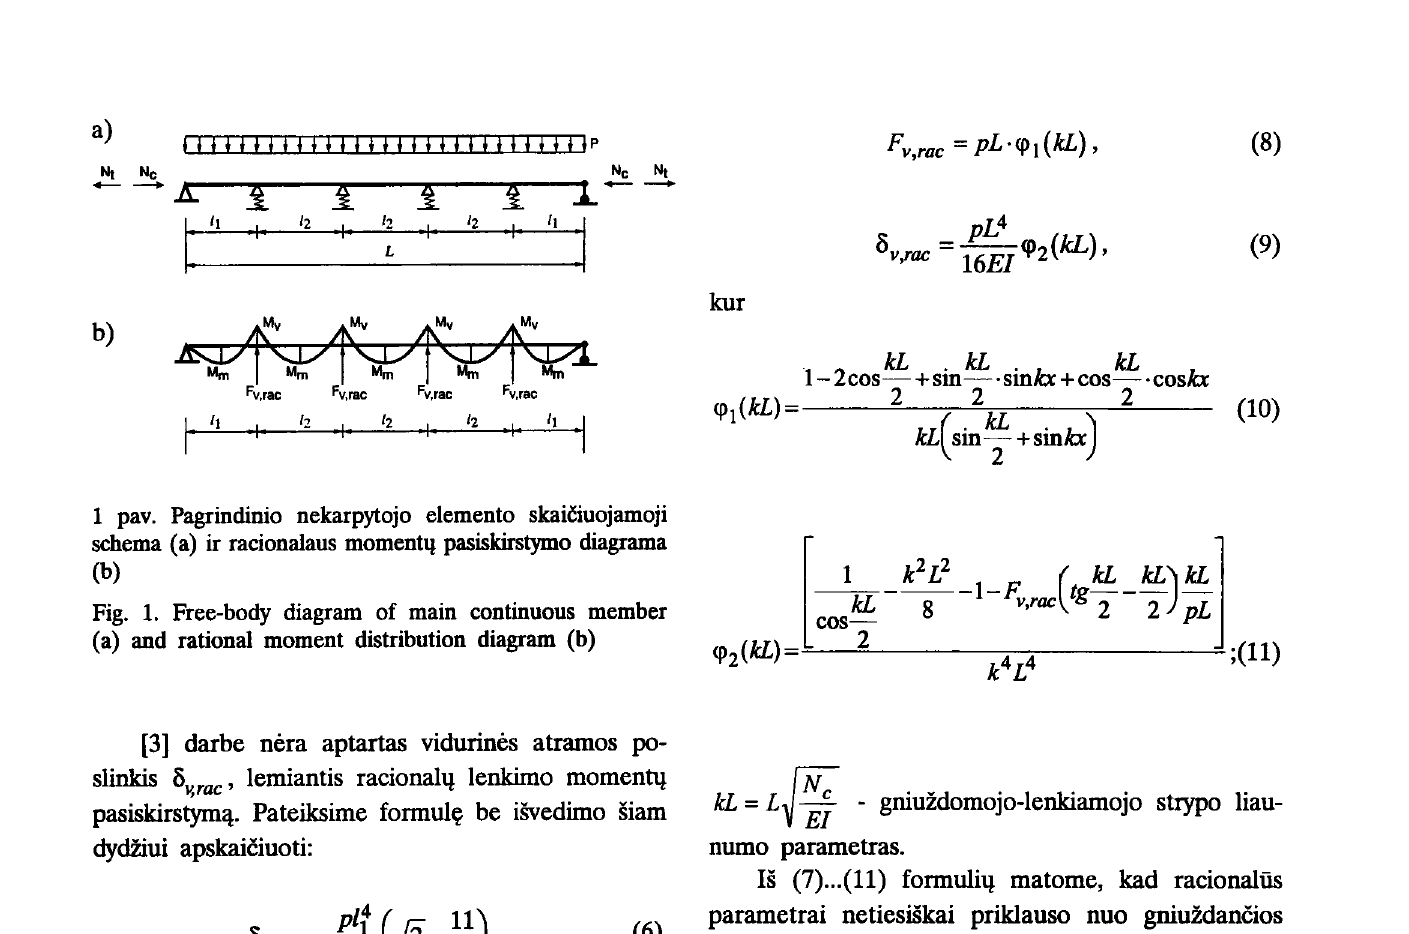
Fig. 1. Free-body diagram of main continuous member (a) and rational moment distribution diagram